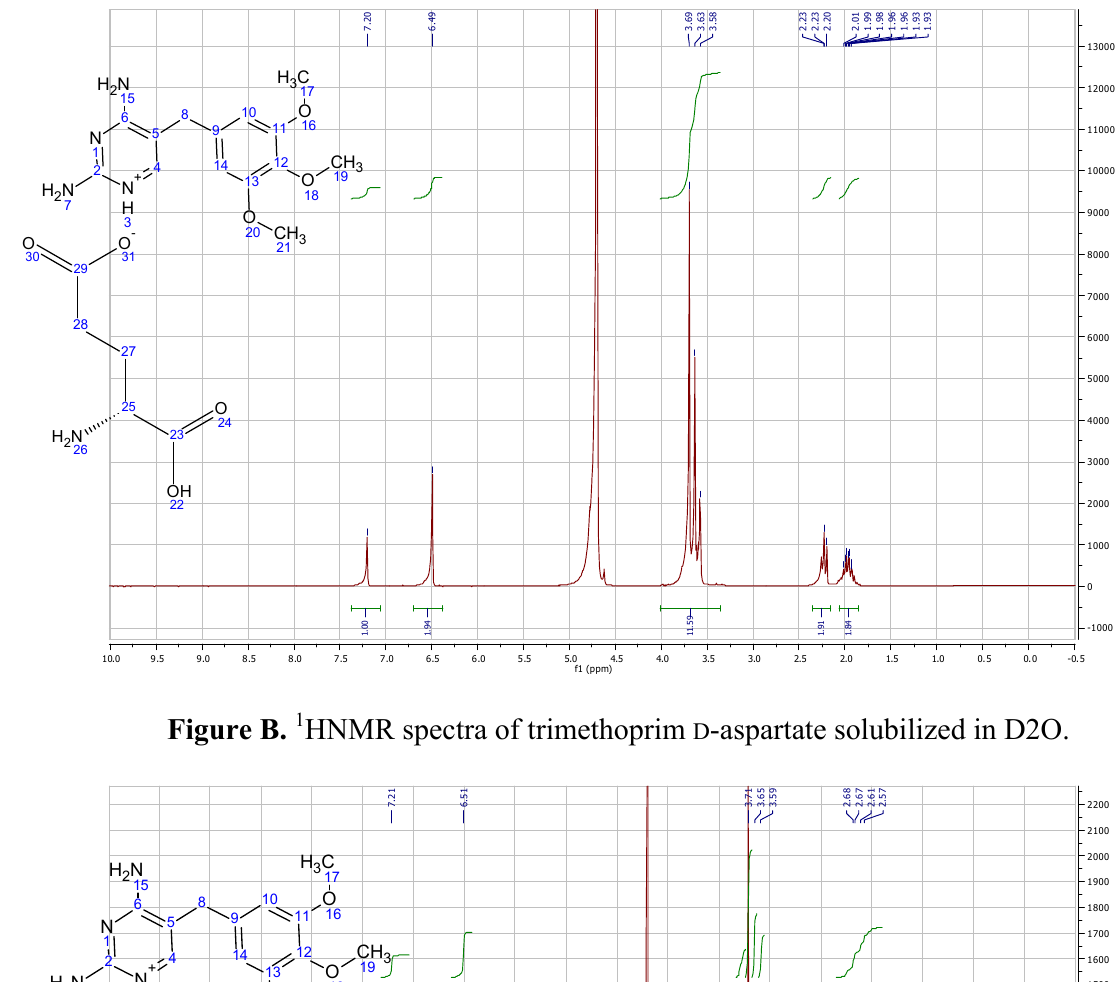
Figure A. 1 HNMR spectra of trimethoprim D -glutamate solubilized in D2O.